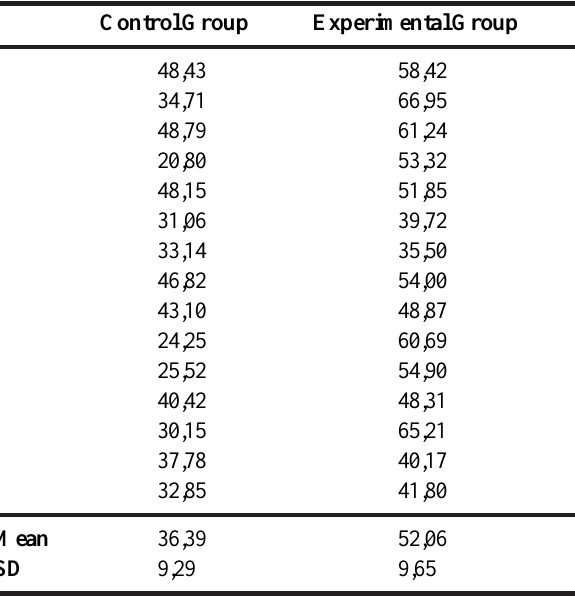
TABLE 1 - Percentages of necrosis in the seventh postoperative day (%).